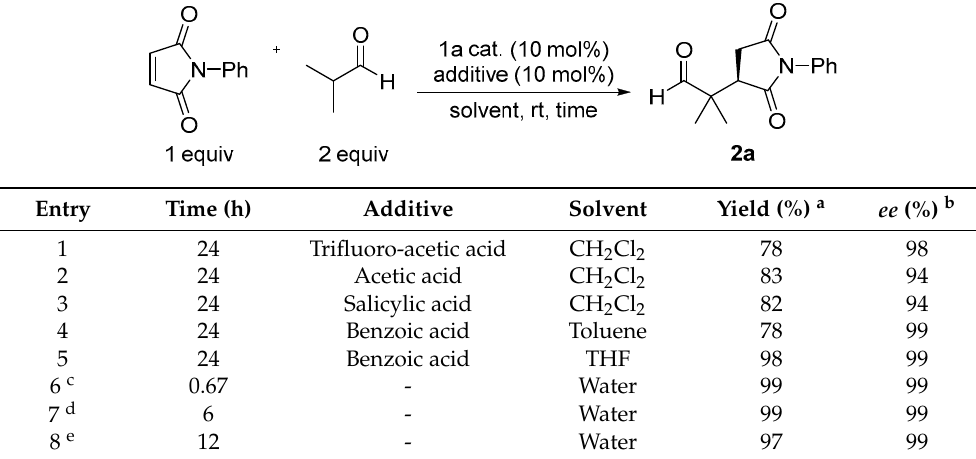
Table 1. Effect of additive and solvent.